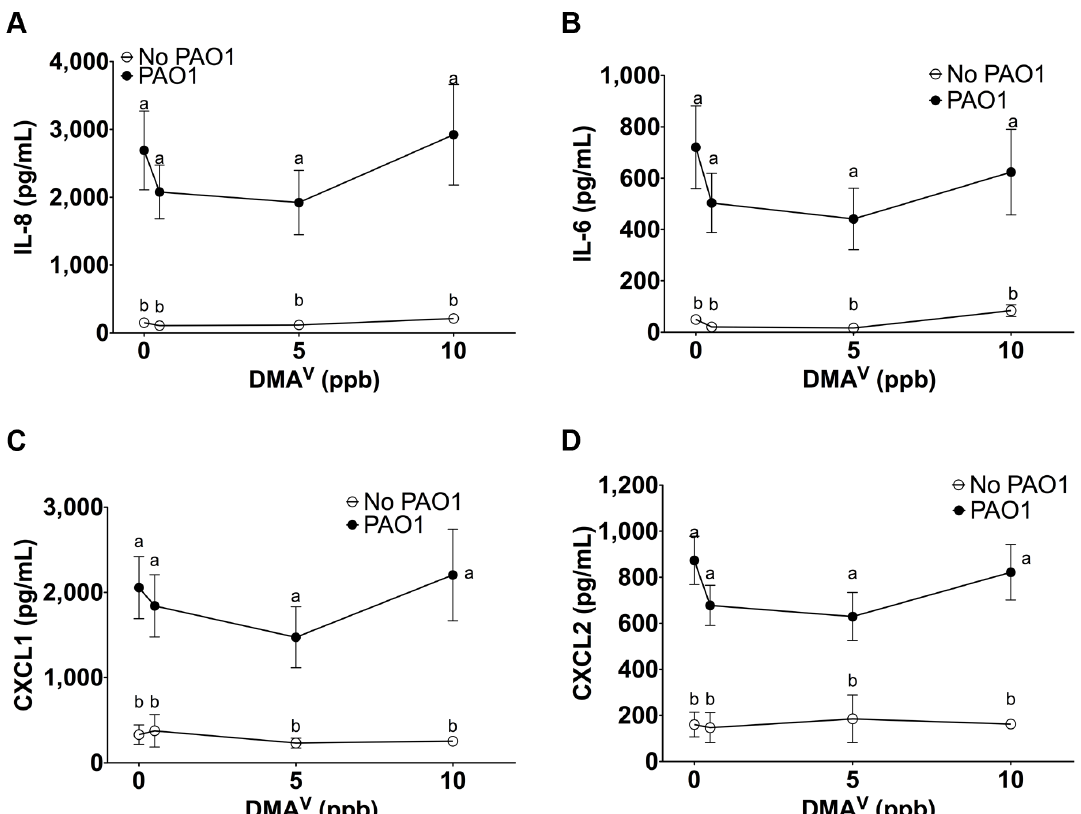
Fig 3. DMA does not alter P . aeruginosa induced immune response. Cytokine secretion by HBEC exposed to DMA V ± P . aeruginosa . n = 4 donors for each treatment. Different letters indicate statistically significant treatment means. Data labeled a are not statistically different from each other but are statistically different from data labeled b (p < 0.05 as measured by one-way ANOVA). Data with the same letter are not significantly different. (A) IL-8 secretion (B) IL-6 secretion (C) CXCL1 secretion (D) CXCL2 secretion.